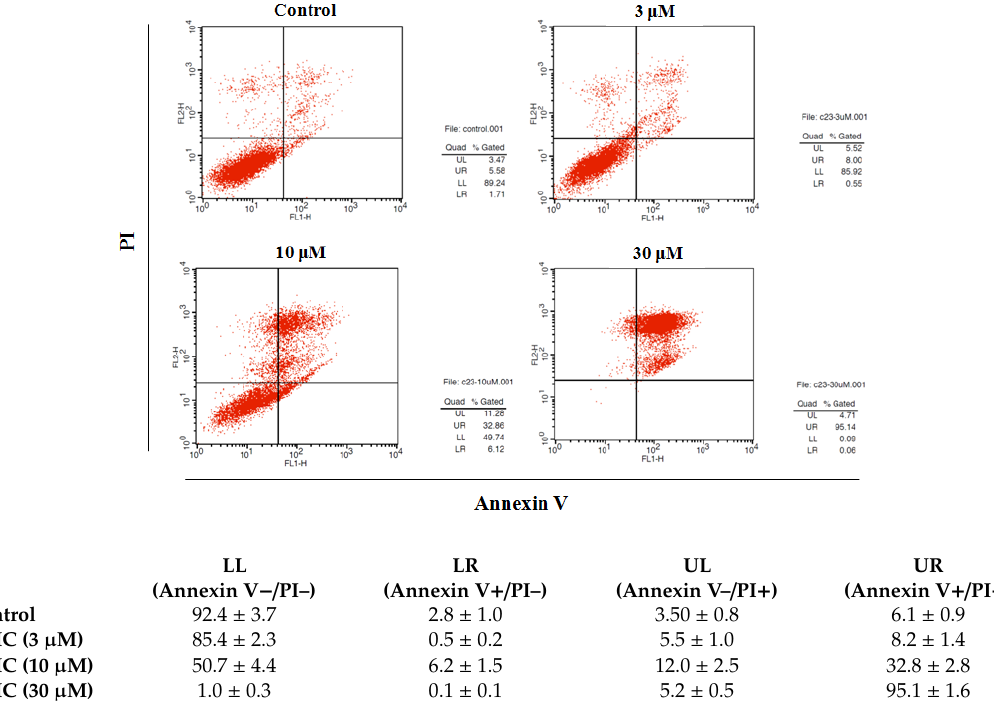
Figure 3. Effect of DMC on apoptosis of PANC-1 cells. Apoptosis quantification using annexin V/PI double staining assay after treatment with DMC (3–30 μM) for 48 h. PANC-1 cells were harvested and stained with PI and annexin V-FITC in darkness for 15 min. Data are presented as the mean ± SD of results from three independent experiments.